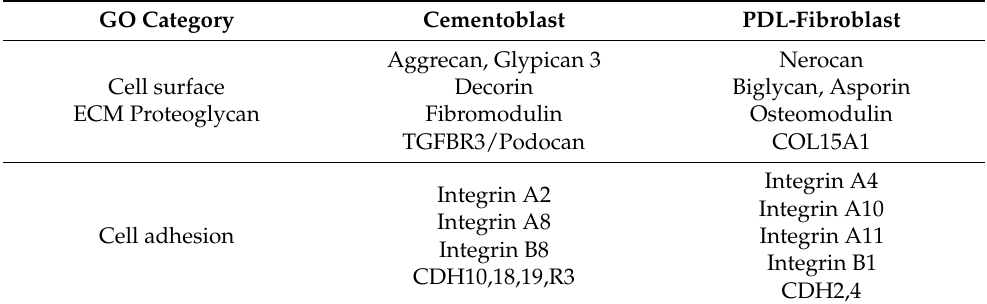
Table 4. The representative genes in GO categories of ECM and membrane molecules and cell adhesion upregulated in BMP7-induced cementoblastic cells and TGF- β 1-induced PDL-fibroblasts. GO Category Cementoblast PDL-Fibroblast Cell surface ECM